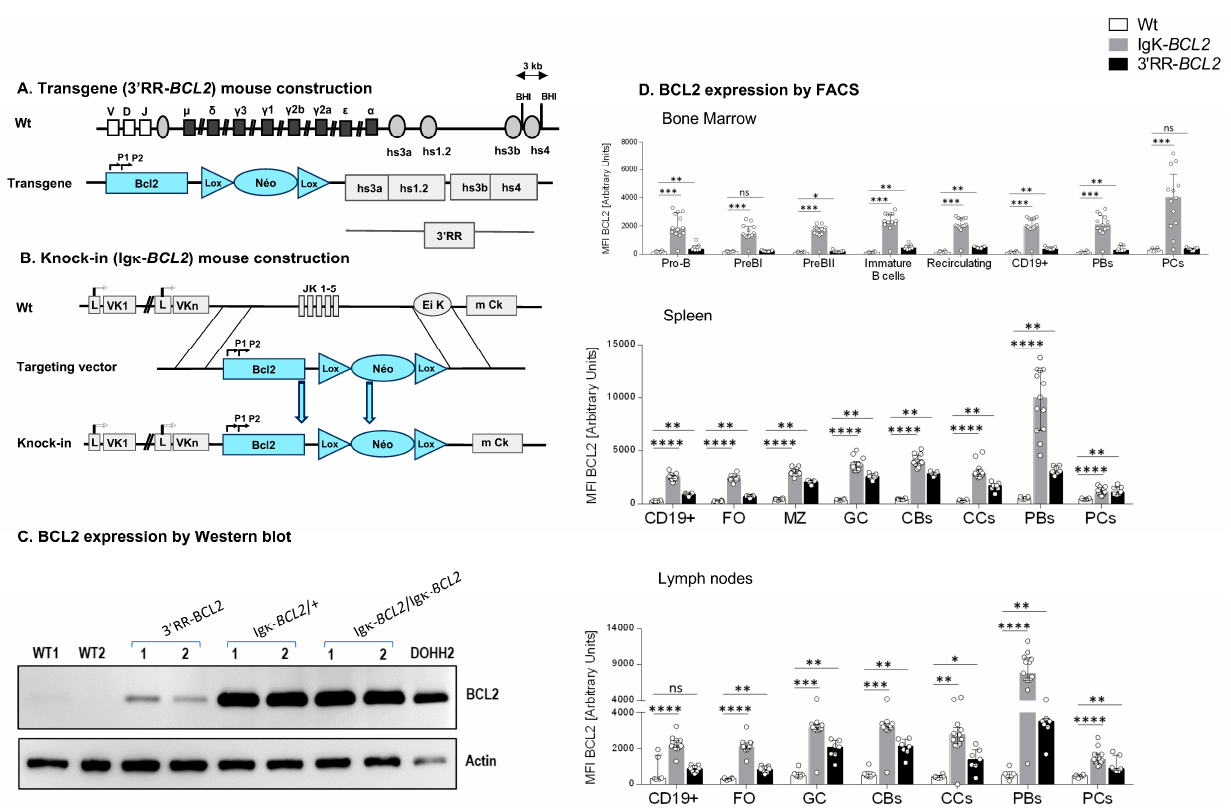
Figure 1. Mouse model construction schematics for ( A ) 3 ′ RR-BCL2 transgenics and ( B ) Ig κ -BCL2 knock-in mice. ( C ) Western-blot evaluation of human BCL2 protein expression in the spleen of WT (negative control), 3 ′ RR-BCL2, Ig κ -BCL2 ∆ /+, Ig κ -BCL2 ∆ / ∆ mice, and in the DoHH2 human cell line (positive control). ( D ) Human BCL2 expression in both mouse models, using the mean fluorescent intensity (MFI) obtained by flow cytometry from bone marrow, spleen, and mesenteric lymph nodes B-cells from unimmunized 3 ′ RR- BCL2 and Ig κ - BCL2 ∆ /+ only. (* p<0.05; ** p<0.01; *** p<0.001; **** p<0.0001).